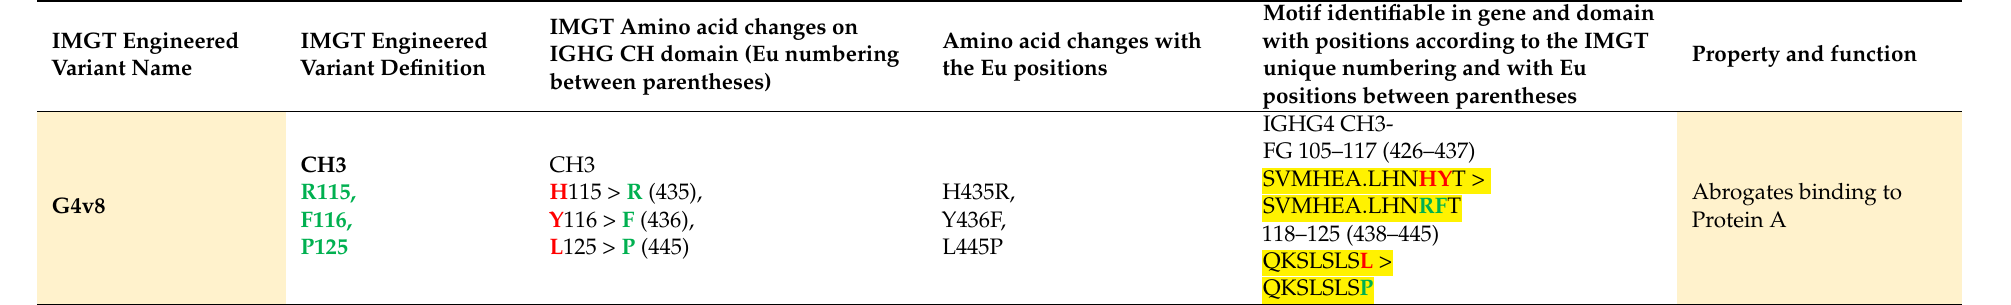
Table 14. IMGT nomenclature, Eu positions and IMGT motif of engineered Fc variants involved in the abrogation of binding to Protein A (Protein A